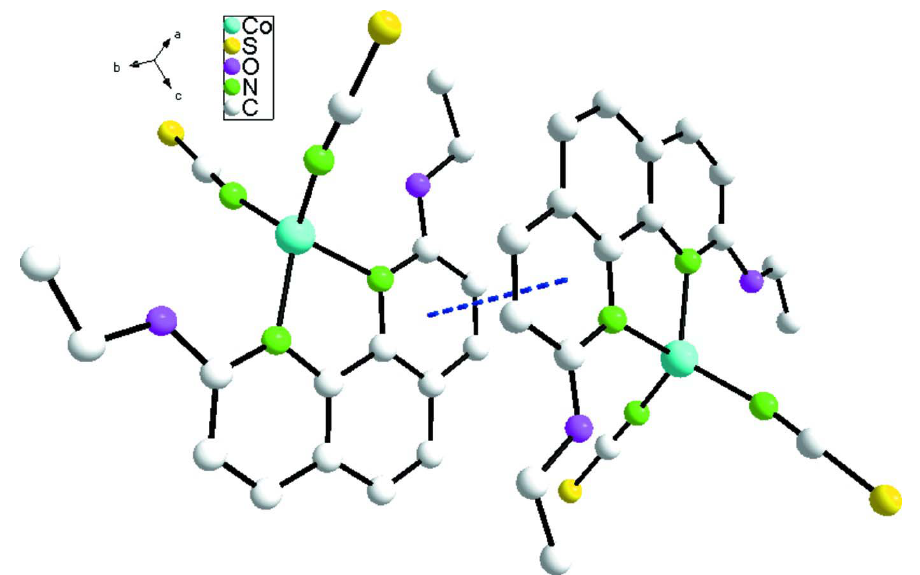
Figure 2 Part of the crystal structure showing intermolecular π – π stacking indicated by dashed lines. All H atoms have been omitted for